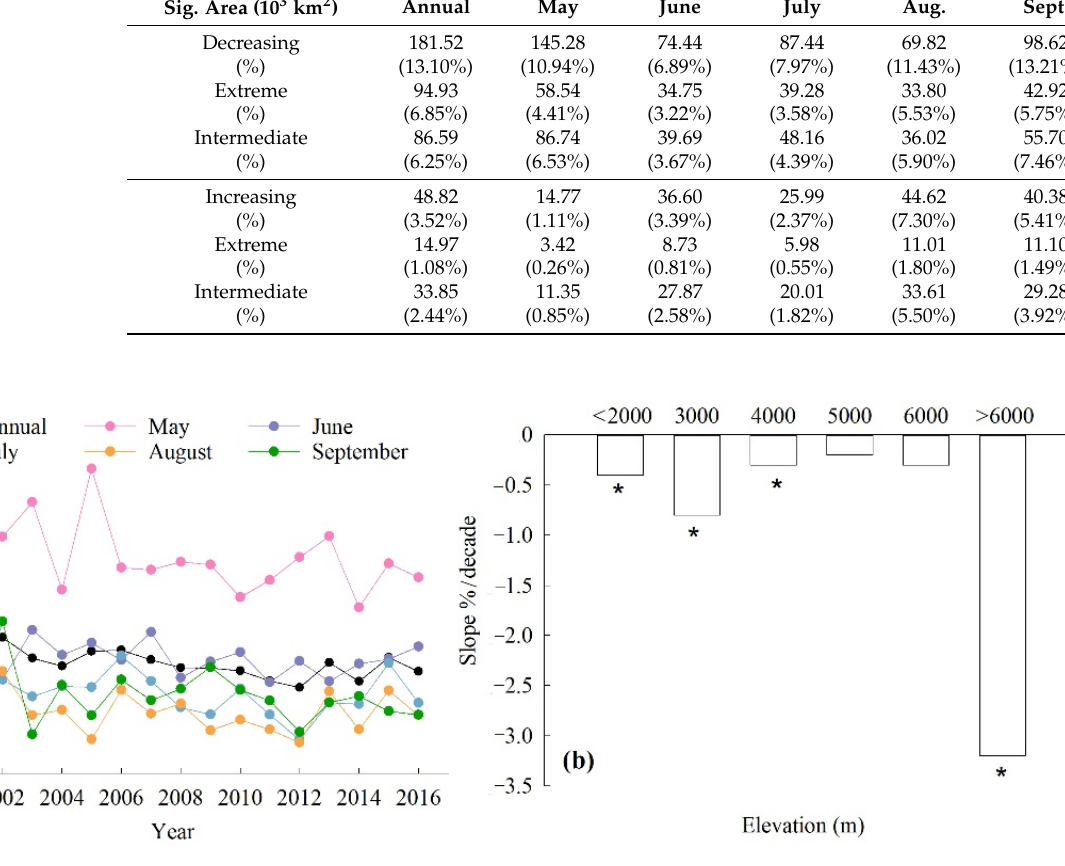
Figure 5. ( a ) The trends of the average annual and monthly albedo and ( b ) the interannual change rates of the average annual albedo for each 1000 m elevation bin on the grassland over the QTP (statistically significant results are indicated for a 99% confidence level (*)). Table 2. The regression trends in average annual and monthly albedo on the grasslands over the QTP during 2000–2016.